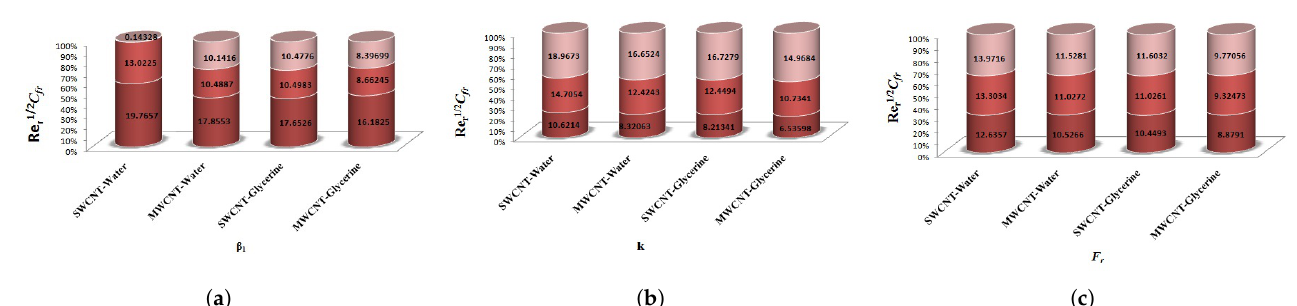
Figure 25. Impact of β 1 , k , F r on Skin-Friction.